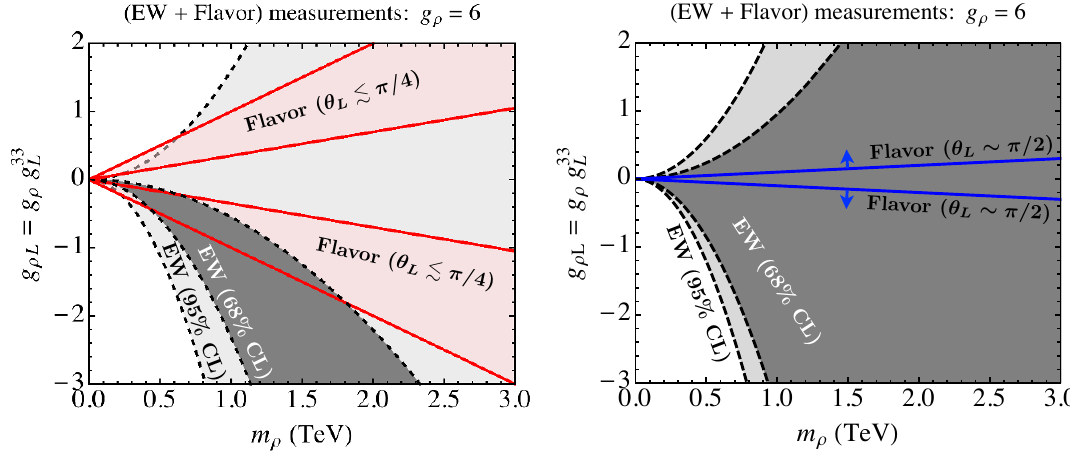
JHEP08(2017)145